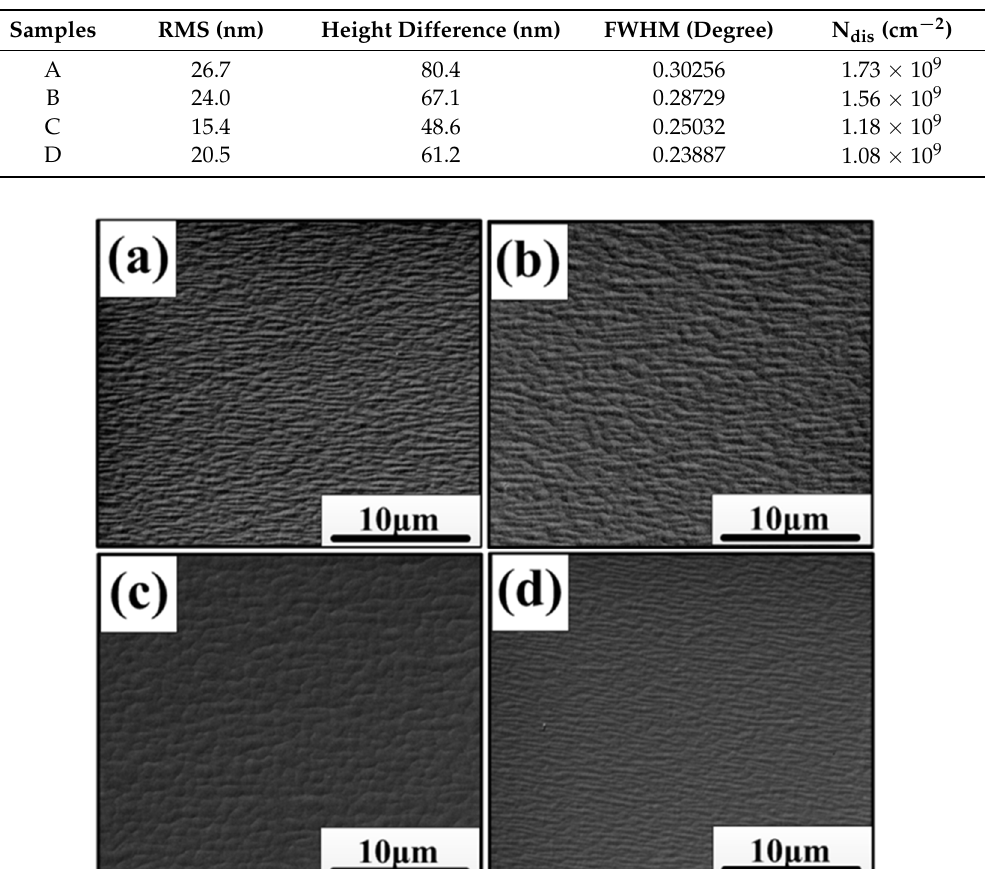
Figure 3. Scanning electron microscope (SEM) images of In 0.82 Ga 0.18 As epitaxial layers of the four samples: ( a ) sample A; ( b ) sample B; ( c ) sample C and ( d ) sample D.